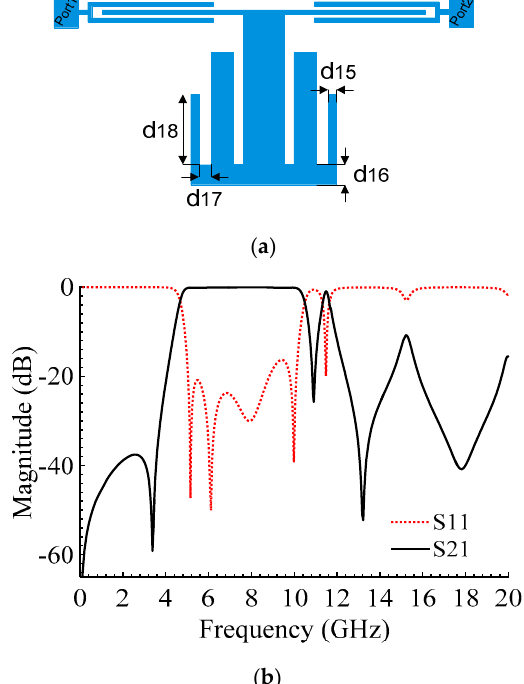
Figure 6. Proposed BPF: ( a ) Layout, d15 = 0.4, d16 = 1, d17 = 0.6, d18 = 3.5 (unit: Mm), ( b ) EM simulation.